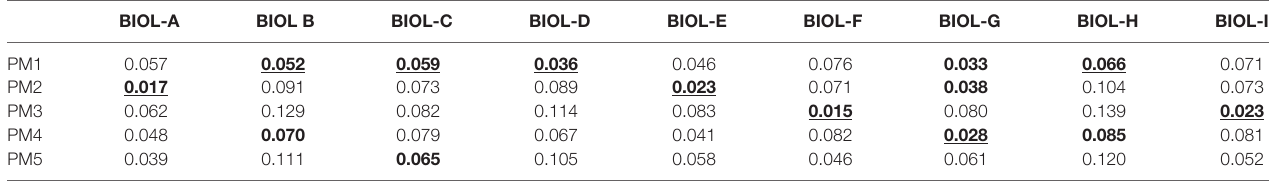
Table 3 | Euclidean distances between similarity-adapted publication vectors of Biology panel members and individual research groups using the similarity matrix of Web of Science Subject Categories. biOl-a